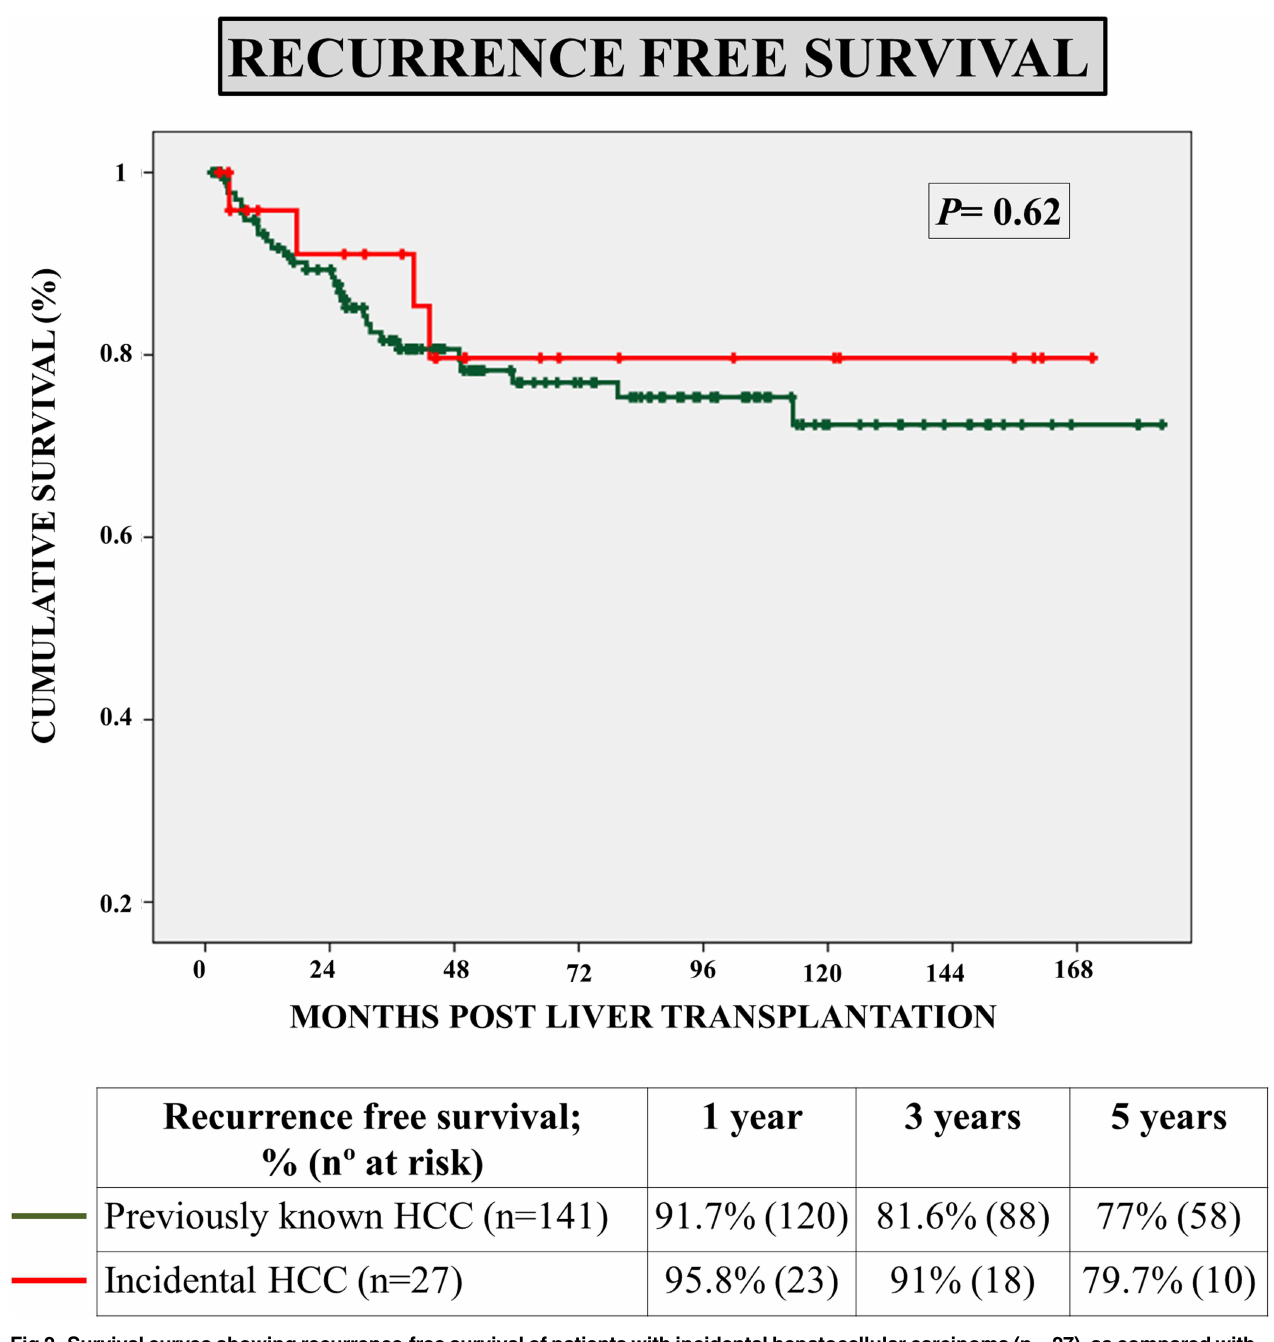
Fig 2. Survival curves showing recurrence-free survival of patients with incidental hepatocellular carcinoma (n = 27), as compared with patients with previously known hepatocellular carcinoma (n = 141).